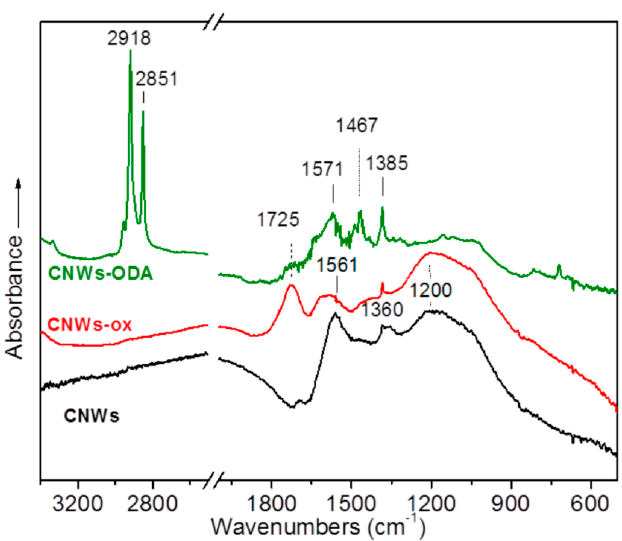
Figure 1. FT-infrared spectra of samples: carbon nanowires (CNWs), oxidized CNWs (CNWs-ox) and CNWs-ODA.